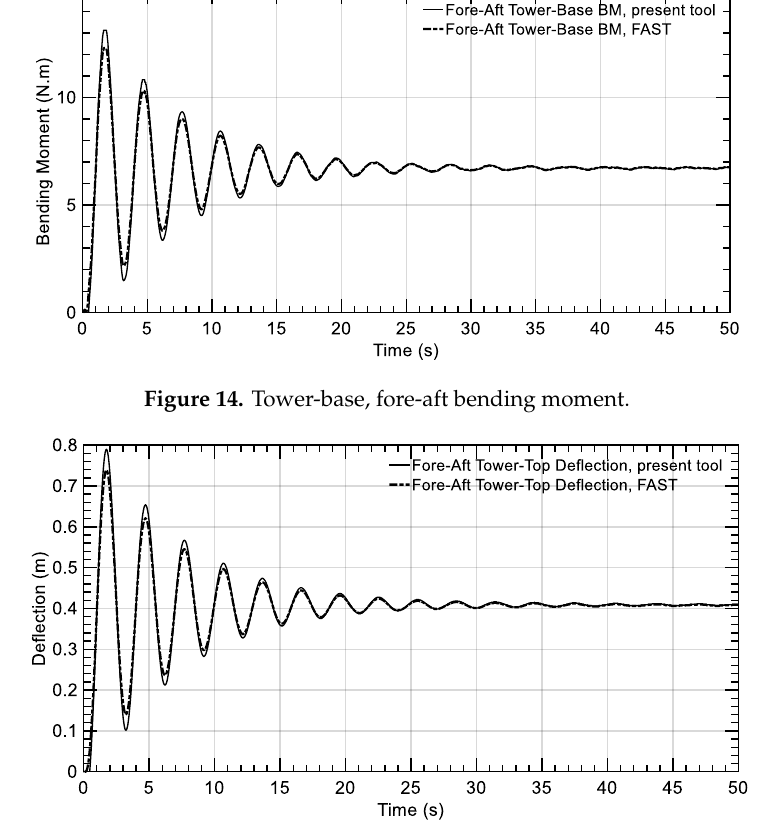
Figure 15. Tower-top, fore-aft deflection.